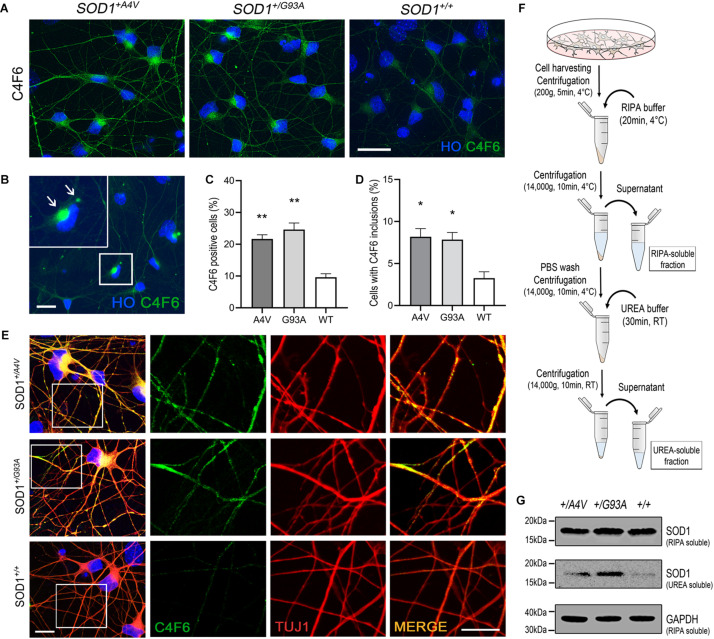
Detection of misfolded and aggregated SOD1 in MN cultures. (A) Immunofluorescence images of MNs showing C4F6 immunoreactivity, a marker for misfolded SOD1. Scale bar, 20 μm. (B) Immunofluorescence of revealed C4F6-positive inclusions and diffuse cytoplasmic immunoreactivity in mutant MNs. Scale bar, 20 μm. (C,D) Quantification of (C) C4F6-positive MNs with cytoplasmic immunoreactivity and (D) MNs with C4F6 inclusions. n = 3 biological replicates (a total of 949 cells with SOD1+/A4V mutation, 876 cells with SOD1+/G93A mutation, and 1072 cells with SOD1+/+ were evaluated). All data shown as means ± SEM. *p < 0.05, **p < 0.01. (E) Immunofluorescence images of MNs showing the localization of misfolded SOD1 in processes of MNs visualized by TUJ1. Scale bars, 10 μm. (F) Schematic of experimental design for extracting RIPA-soluble and UREA-soluble fractions from MN cultures. (G) Western blots showing SOD1 in RIPA-soluble and UREA-soluble fractions. GAPDH was used as a loading control. n = 3 biological replicates.